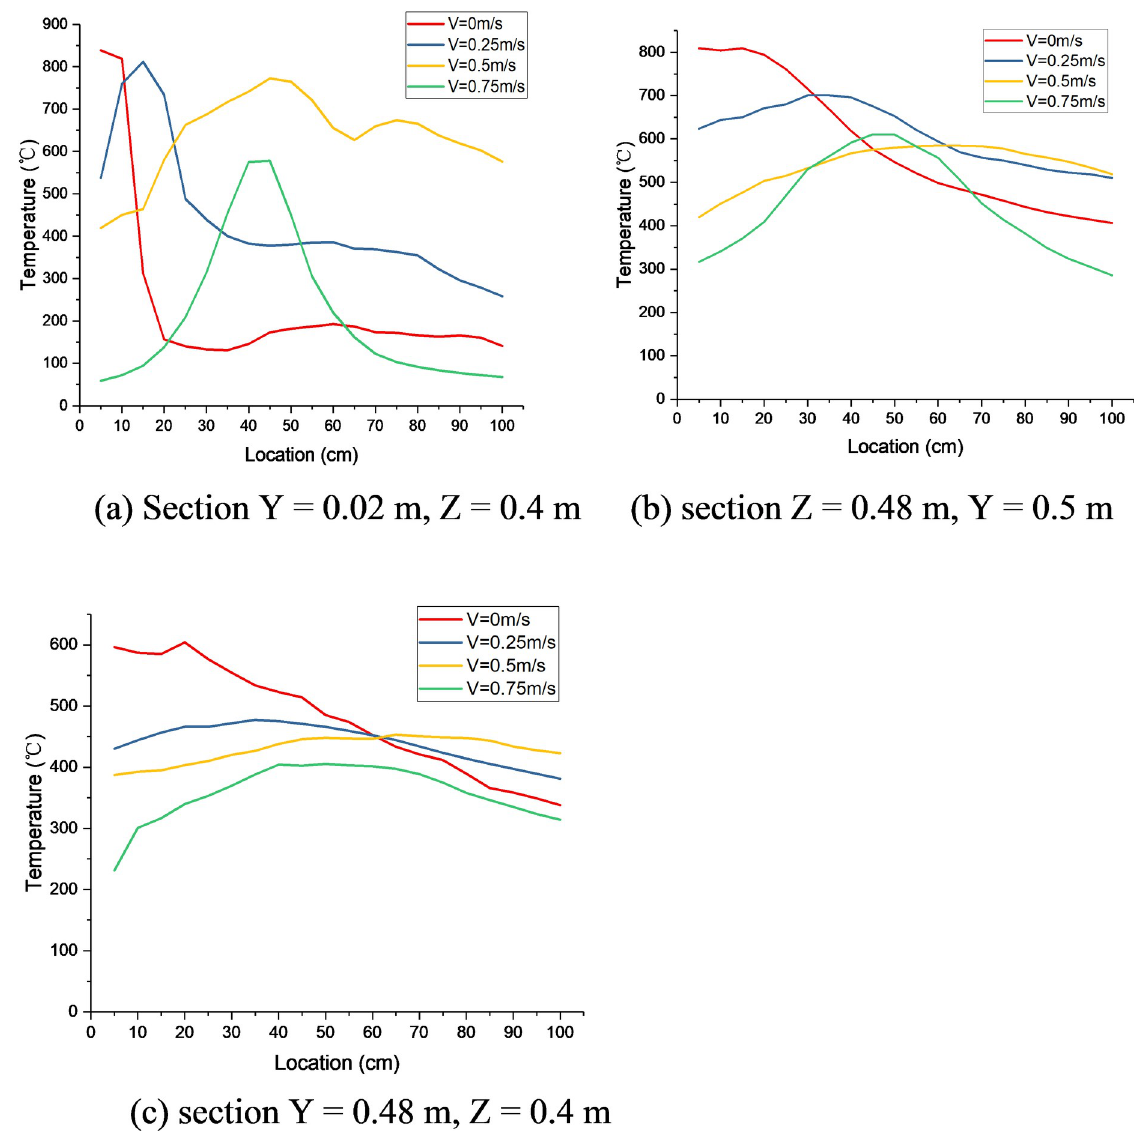
Fig 14. Horizontal temperature curves of timber linings at 460 s in the tunnel for different wind